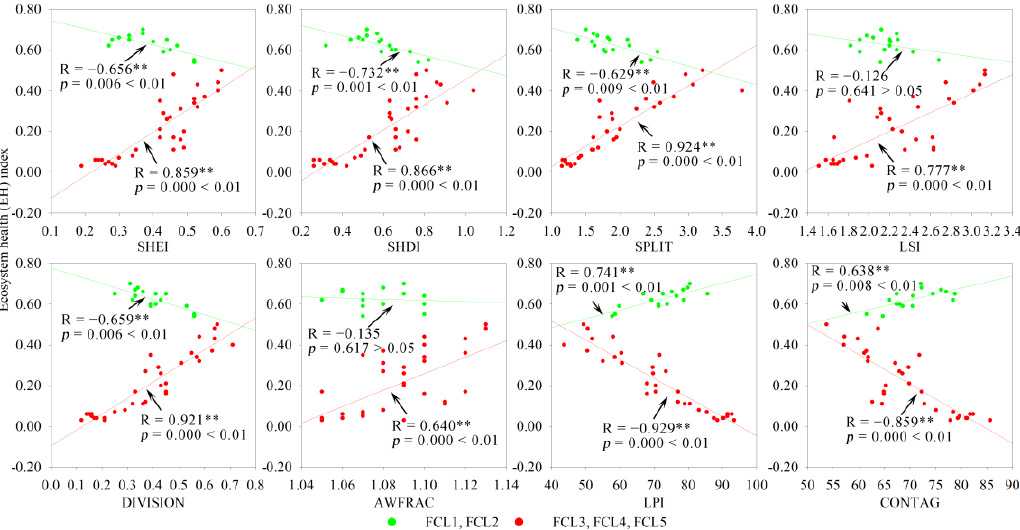
Figure 9. Correlation of landscape composition and configuration with ecosystem health in forestland + construction land landscape. FCL, forestland + construction land landscape; SHEI, Shannon’s evenness index; SHDI, Shannon’s diversity index; SPLIT, splitting index; LSI, landscape shape index; DIVISION, landscape division index; AWFRAC, area-weighted mean fractal dimension index; LPI, largest patch index; CONTAG, contagion index. ** p -value at 1% level.